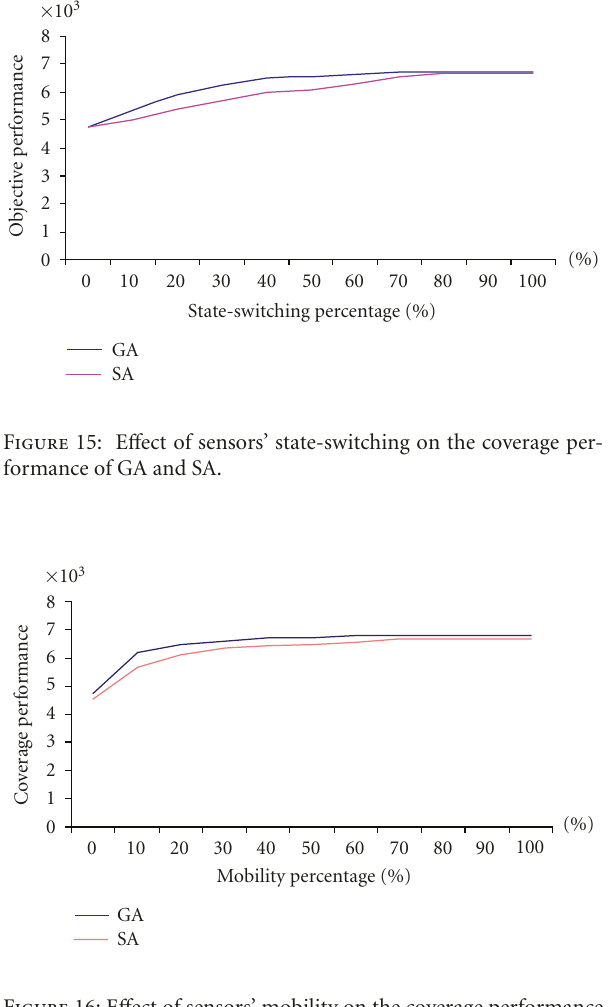
Figure 18: E ff ect of sensors’ reliability with di ff erent numbers of sensors on the coverage performance of